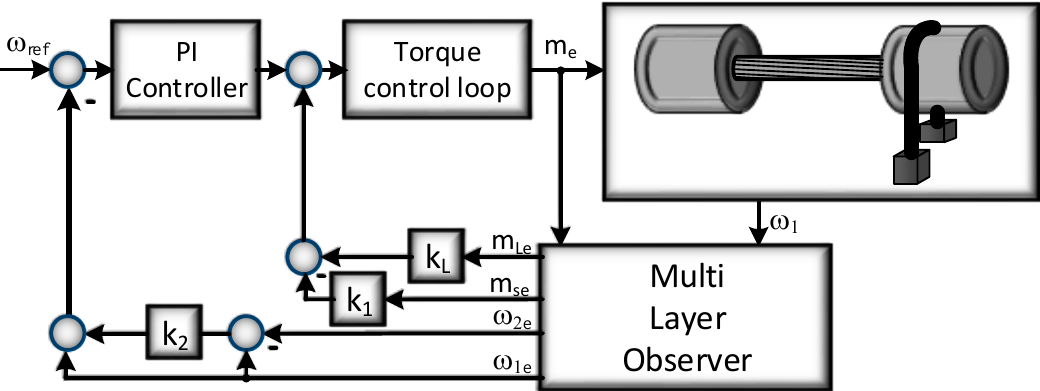
Figure 2. Block diagram of the analysed control structure.